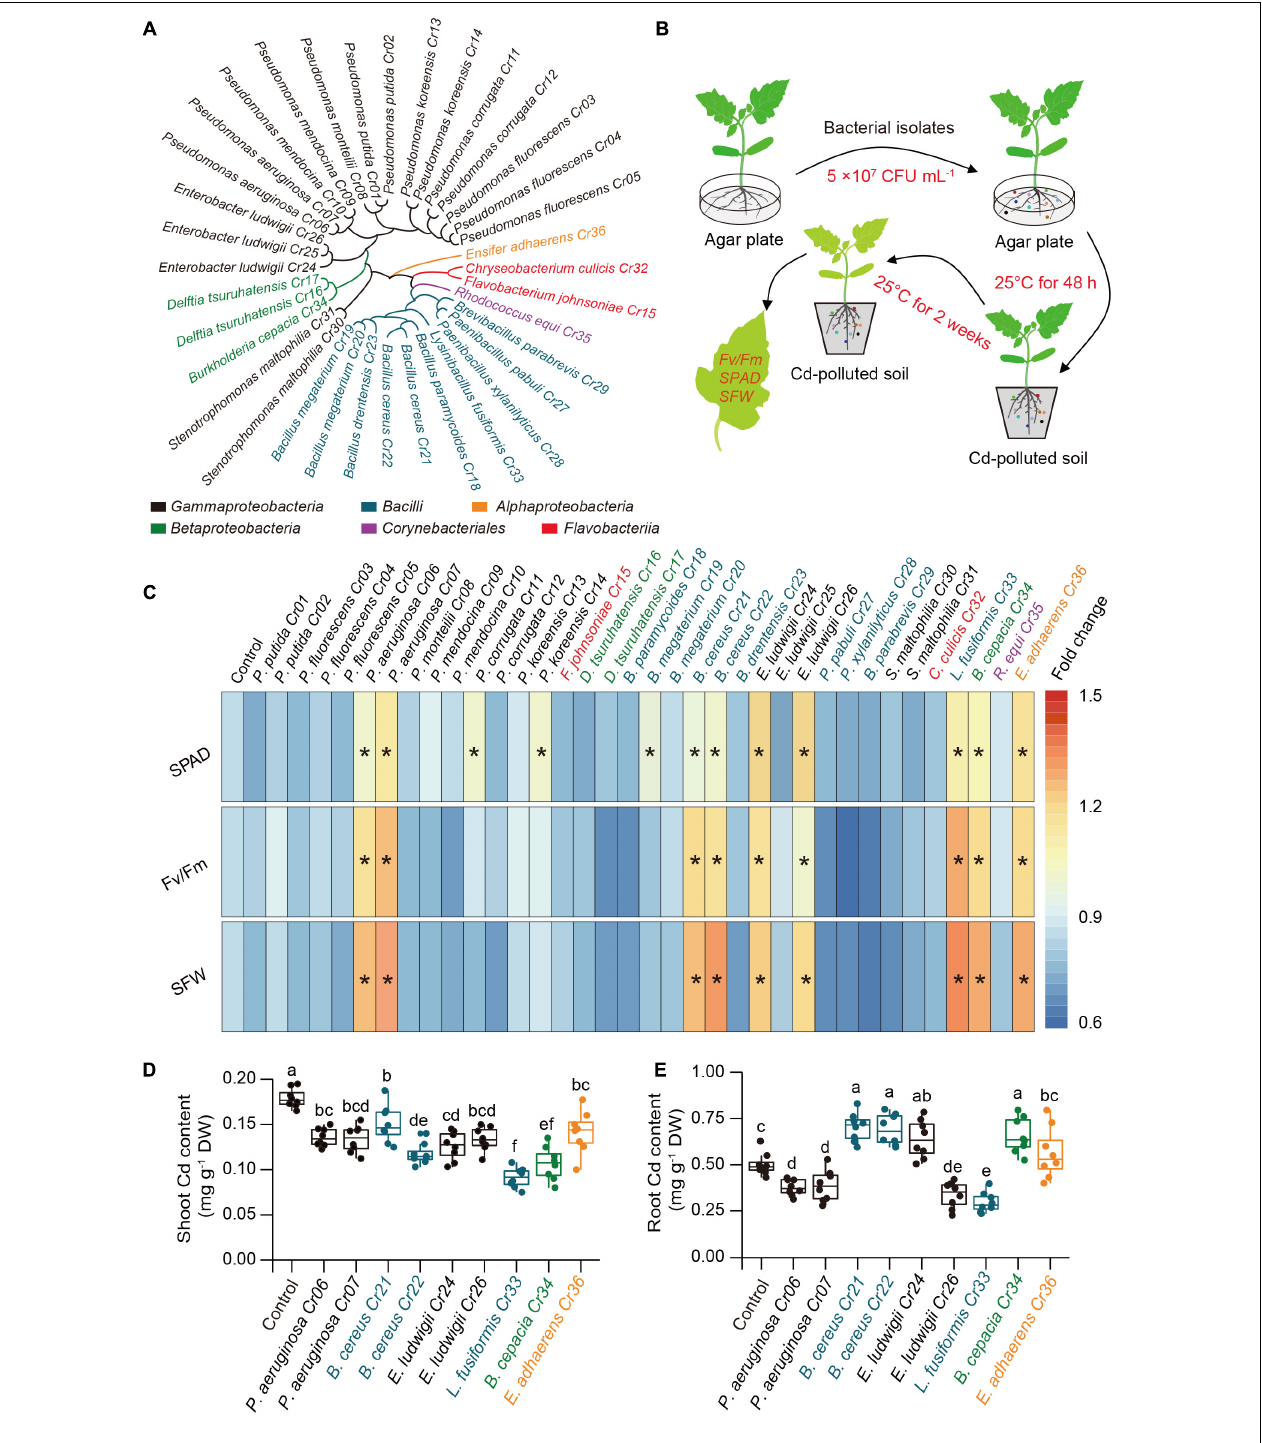
FIGURE 1 | Effects of soil drench with endophytic bacteria on Cd resistance in tomato plants. (A) Taxonomic cladogram of bacterial isolates. (B) High-throughput assays of Cd-detoxifying bacterial isolates. Ten-day-old tomato roots were co-cultured with or without bacterial suspension on agar plate at 25 ◦ C in the dark for 48 h. the non-inoculated (control) and inoculated plants were then transplanted into Cd-contaminated soils (100 mg Cd kg − 1 soil) at 25 ◦ C. After 2 weeks of culture, the values of Fv/Fm, SPAD and SFW were determined for assessing the ability of plants to tolerate Cd stress. (C) Heatmap analysis for Fv/Fm, SPAD and SFW. Asterisks indicated significant differences between the control and inoculated plants ( n = 8 biological replicates) using Student’s test at p < 0.05. (D) Shoot and (E) root Cd content. Different letters indicated significant differences among different bacterial strain-inoculated plants ( n = 8 biological replicates) using Duncan’s multiple range test at p <